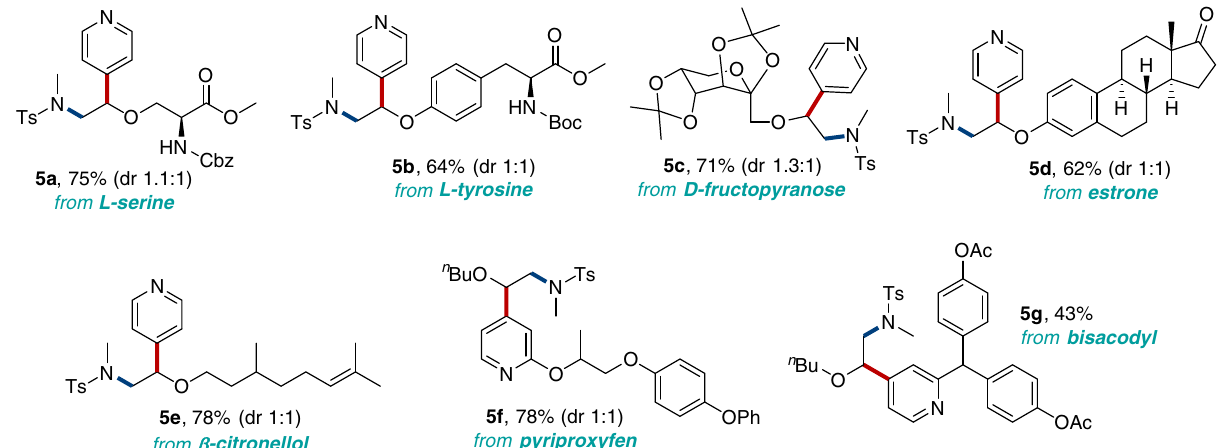
Fig. 7 Late-stage aminopyridylation of biorelevant molecules. The reactions of derivatives of L-serine, L-tyrosine, D-fructopyranose, estrone, β -citronellol, pyriproxyfen, and